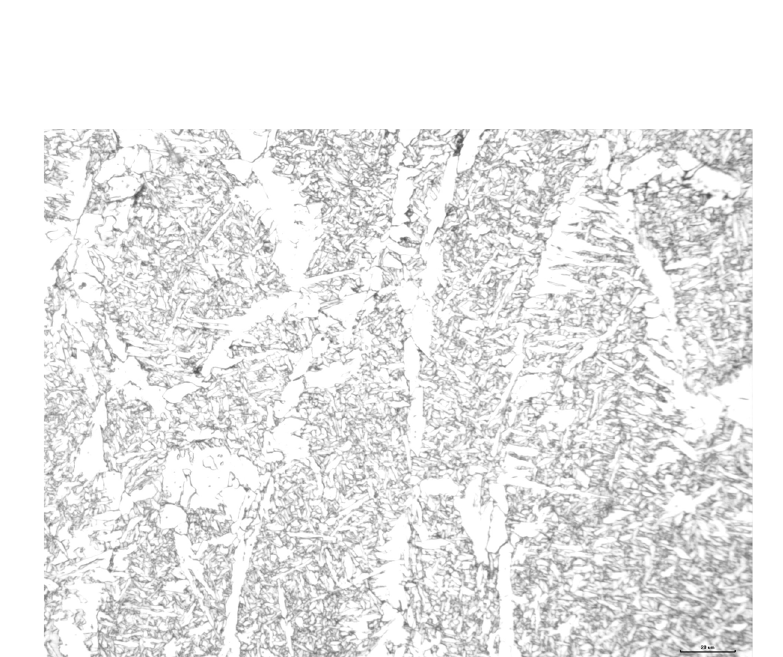
Fig. 10 Structure of filling layer of failed girth